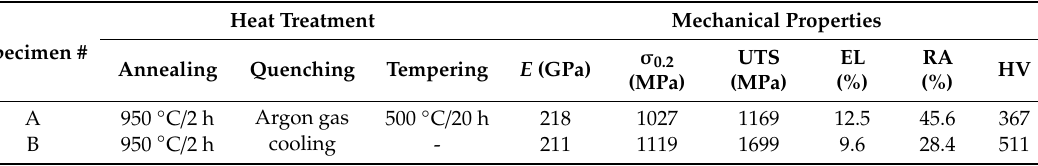
Table 2. Heat treatment procedures and mechanical properties of the two kinds of steel specimens used in this